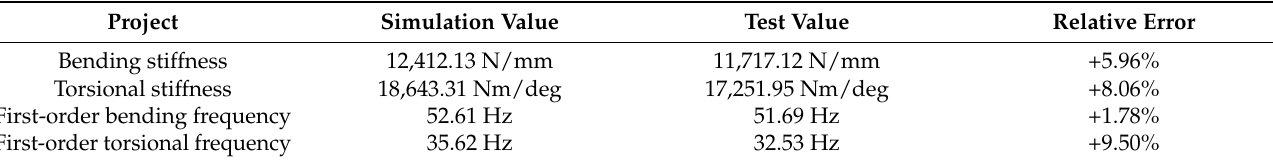
Table 5. Test results of static stiffness and low-order modal frequency of BIW.